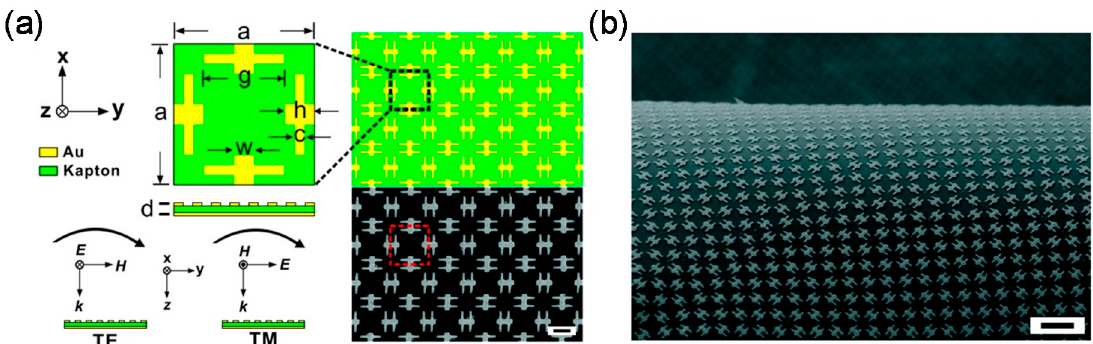
Figure 10. ( a ) Schematic illustration and ( b ) SEM image of a flexible MIM ‐ PMA. Figures are adapted with permission from Reference [86]. © 2011 American Chemical Society.